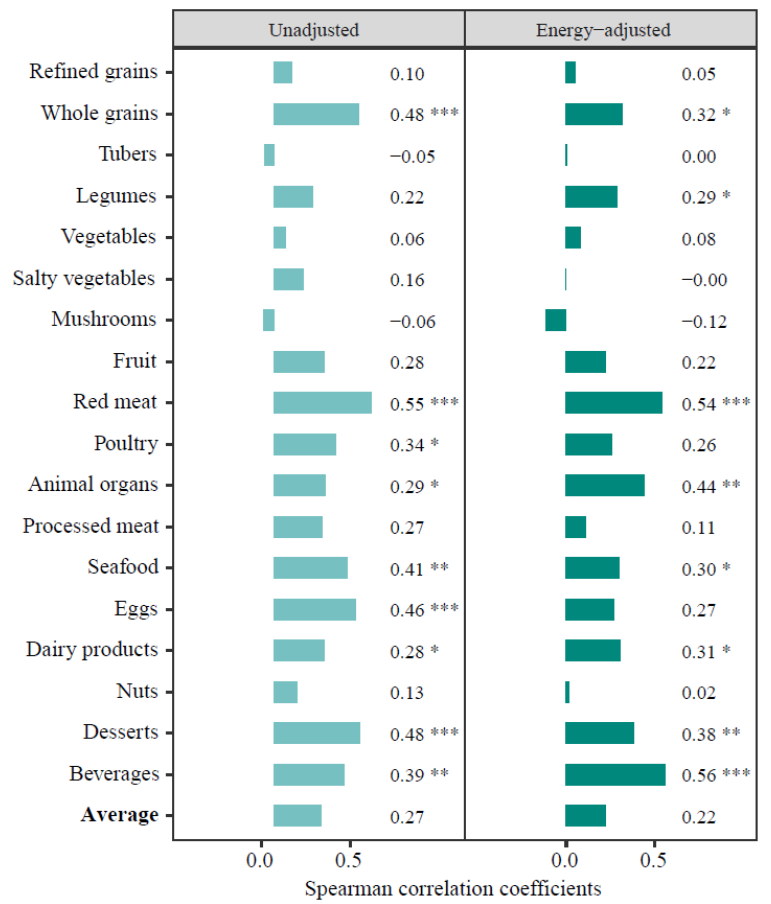
Figure 2. Spearman correlation coefficients ( r s ) of food group intakes estimated by the SFFQ and the 24-HDRs. Energy-adjusted: total energy intake was adjusted. * p < 0.05; ** p < 0.01; *** p < 0.001.